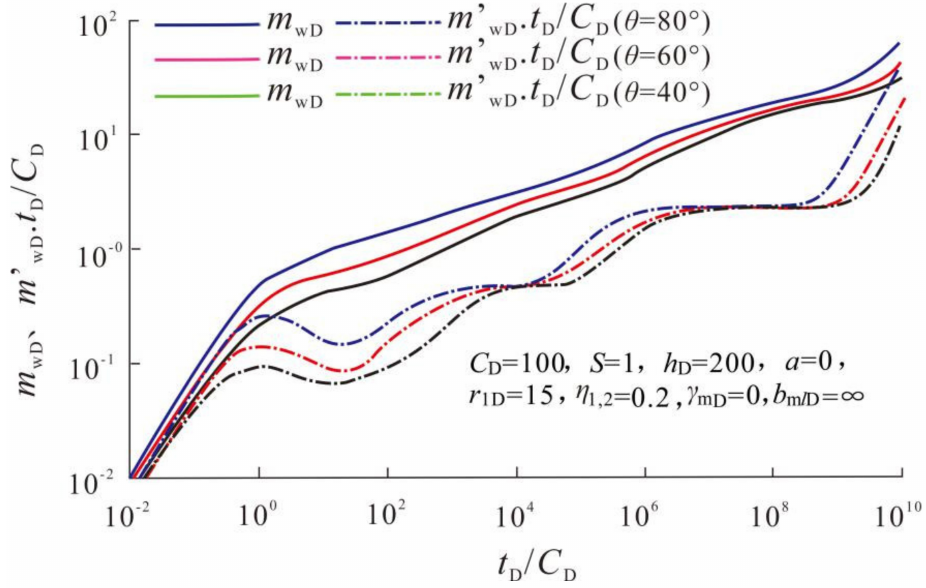
Figure 5. Effect of the well angle on dynamic pseudo pressure